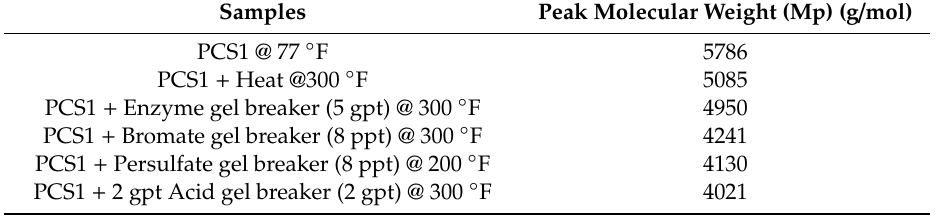
Figure 15. GPC results of polymeric clay stabilizer 1 exposed to different gel breakers (persulfate: 8 ppt, bromate: 8 ppt, acid: 2 gpt, enzyme: 5 gpt) after 24 h at 200–300 °F. Table 4. Peak molecular weight values of polymeric clay stabilizer 1 with gel breaker samples after 24 h. Samples